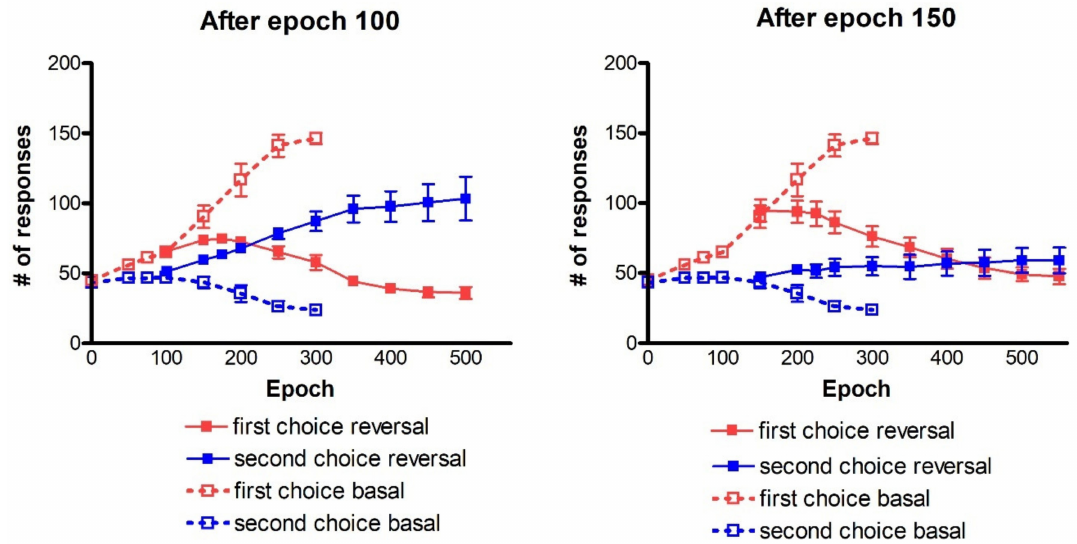
Figure 9. Temporal pattern of the responses in the test trials with reference to a four-action choice, when the reversal learning is performed after 100 epochs of previous basal training (left panel) and after 150 epochs (right panel). All results refer to the post-post rule. The dashed dotted lines with open squares represent the results of the previous basal training (the same results as in the left panel of Figure 8). The continuous lines with filled squares represent results in the reversal learning phase. All points are the result of 200 test trials, performed by using the synapses obtained at the given instant. The phasic dopaminergic drop was 0.5 in the basal training, 1.0 in the reversal training performed after 100 epochs, and 1.5 in the reversal training performed after 150 epochs It is worth noting that the term “first choice” refers to the actions more often rewarded during the basal training with a given stimulus (probability of reward 0.8), which become the second choice during the reversal (probability of reward 0.3). The second choice refers to actions with reward probability as low as 0.3 during training, and 0.8 during reversal